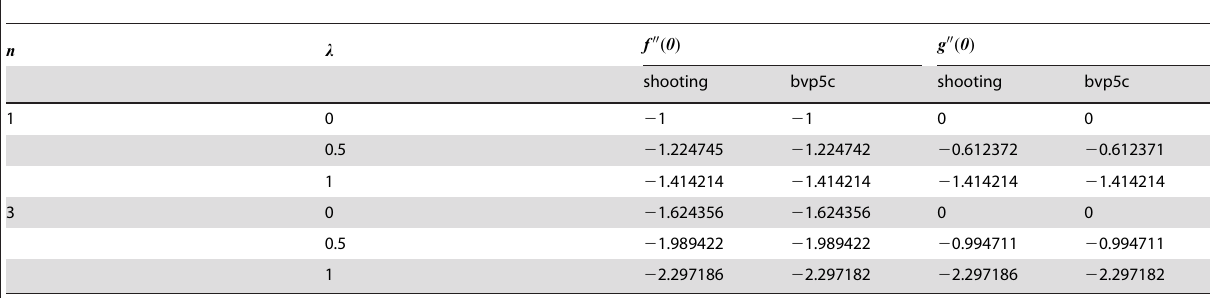
Table 2. Numerical values of f 00 (0) and g 00 (0) for different values of n and l .